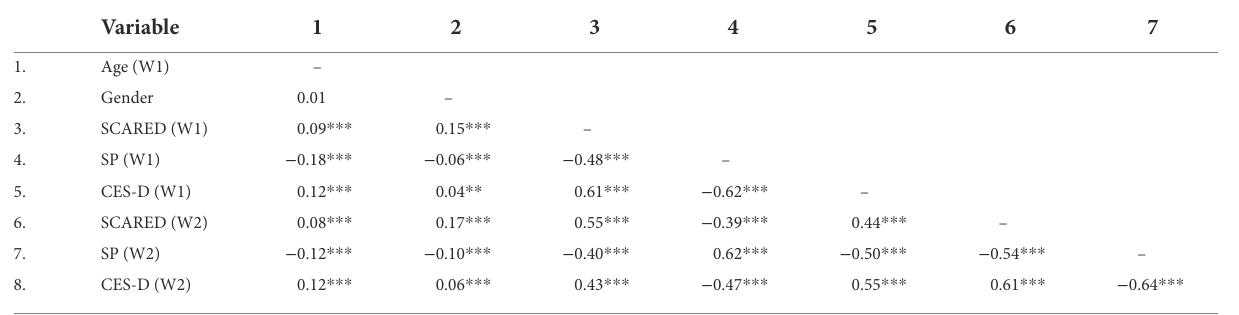
TABLE 2 Correlations between different variables.